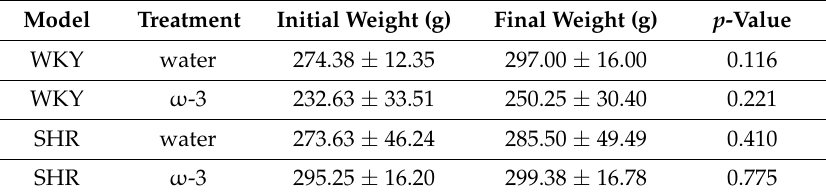
Table 1. Body weight of animals that received supplementation with water (control) or ω -3 in the initial phase and ending of the treatment (2 weeks).